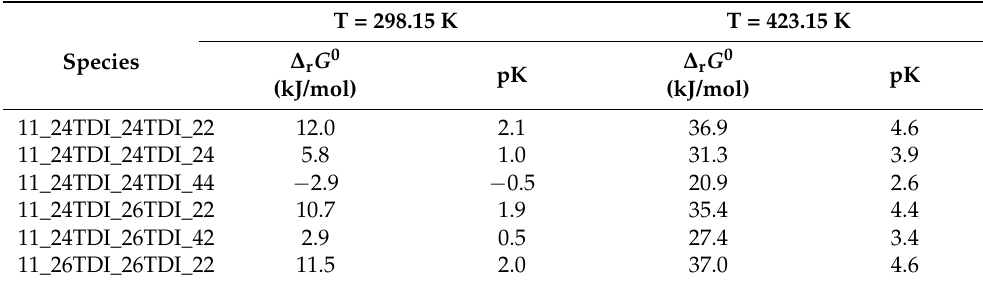
Table 2. Reaction Gibbs free energies ( ∆ r G 0 ) and the negative logarithm of equilibrium constant (pK = − logK) of the type ‘11’ TDI dimerization resulted in different uretdione formation calculated at the G3MP2B3 level of theory. T = 298.15 K T = 423.15 Species